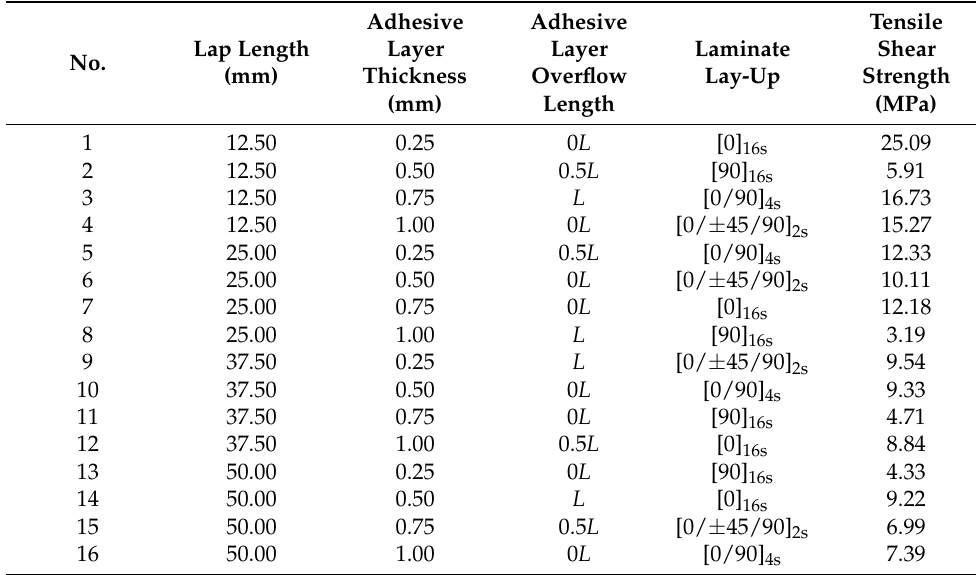
Table 4. Orthogonal experimental design and results.